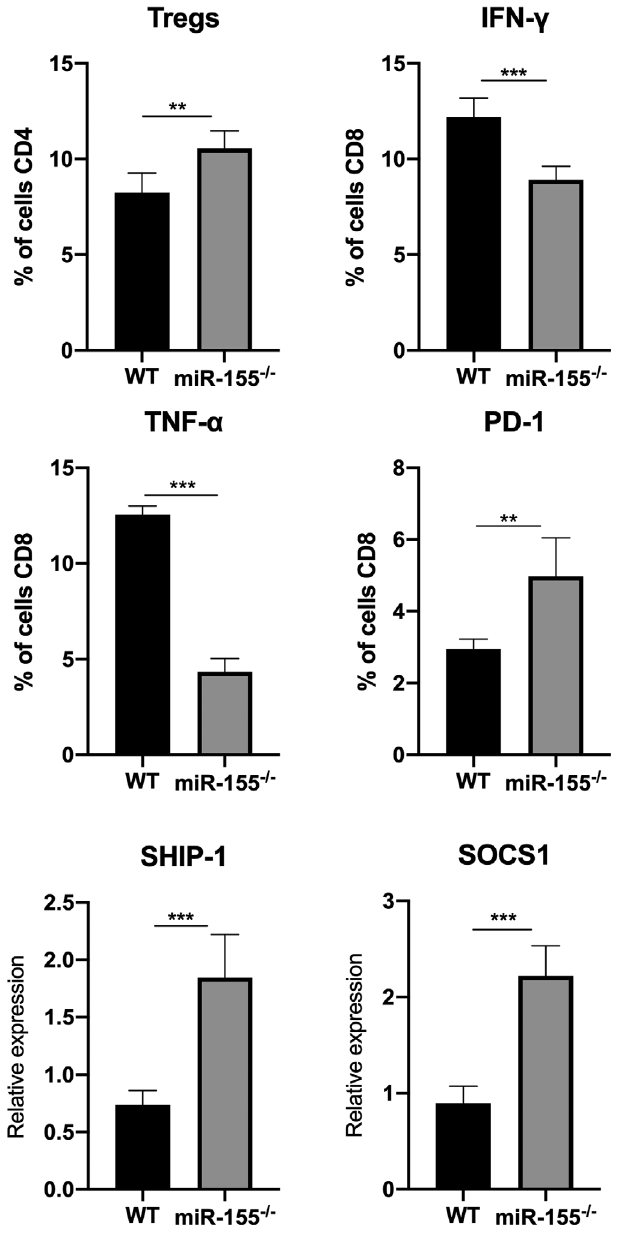
Figure 4. miR-155 de fi ciency exacerbated CD8 + T cell exhaustion by targeting to SHIP-1 and SOCS1. Spleens were collected from each mouse in the WT and miR-155 (cid:1) / (cid:1) groups. The percentages of Tregs, IFN- c CD8 + T, TNF- a CD8 + T and PD1 CD8 + T cells were analysed by fl ow cytometric analysis. The expressions of SHIP-1 and SOCS1 were estimated by qRT-PCR. Data are shown from one representative experiment of three independent experiments and presented as a mean ± SD. *** p < 0.001; ** p <